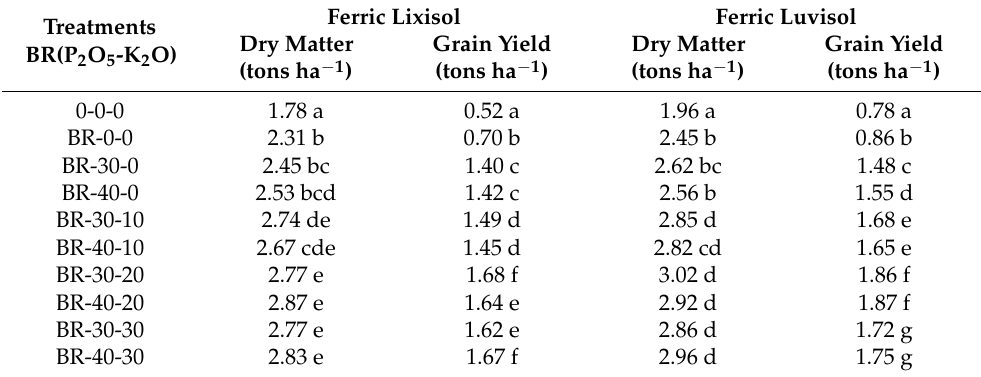
Table 2. Effect of inoculant and fertilizer application on cowpea dry matter and grain yield.